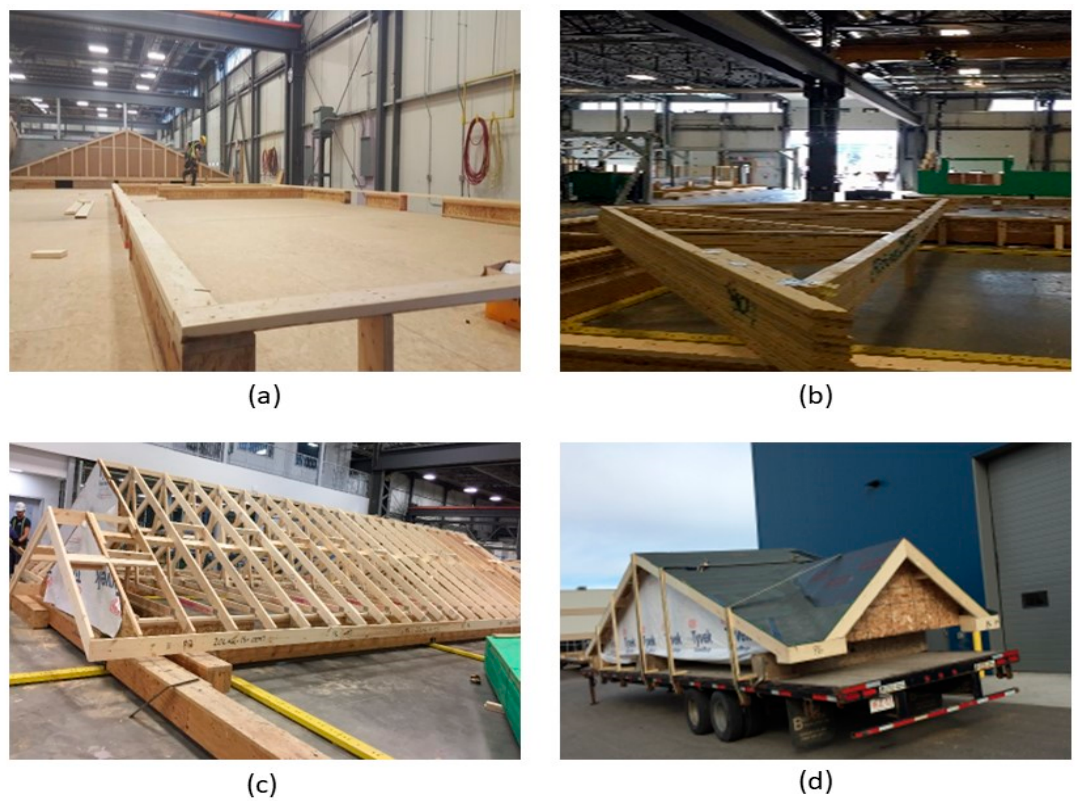
Figure 1. Roof production ( a ) setup jig, ( b ) unloaded truss, ( c ) attaching roof components, and ( d ) small roof module on the transportation trailer (courtesy of ACQBUILT Inc., Edmonton, AB, Canada) [6].